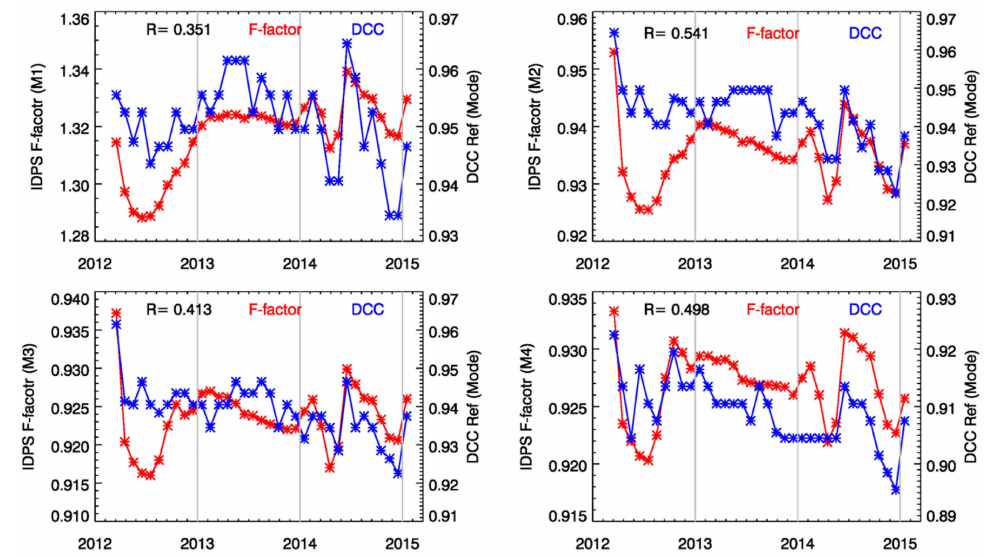
Figure 5. Comparison of DCC mode and IDPS F-factor time series for bands M1–M4 (R represents correlation coefficient).